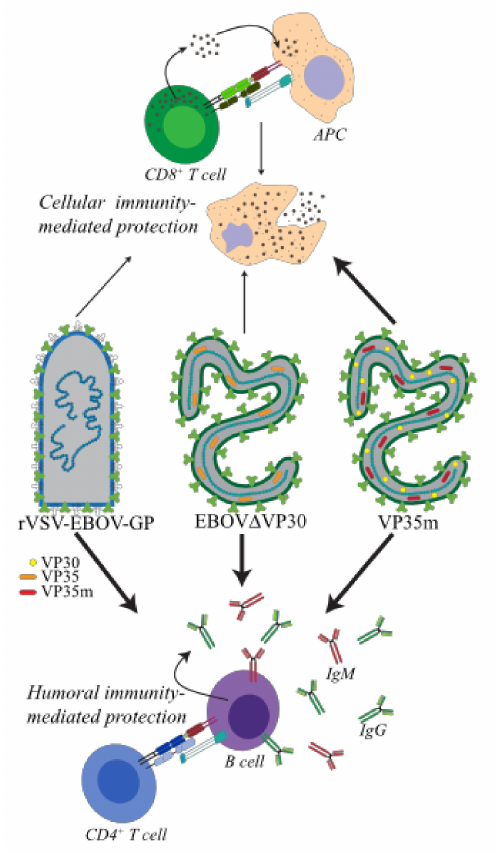
Figure 3. Mechanisms of protection of rVSV-EBOV-GP in comparison to whole-virus candidate EBOV